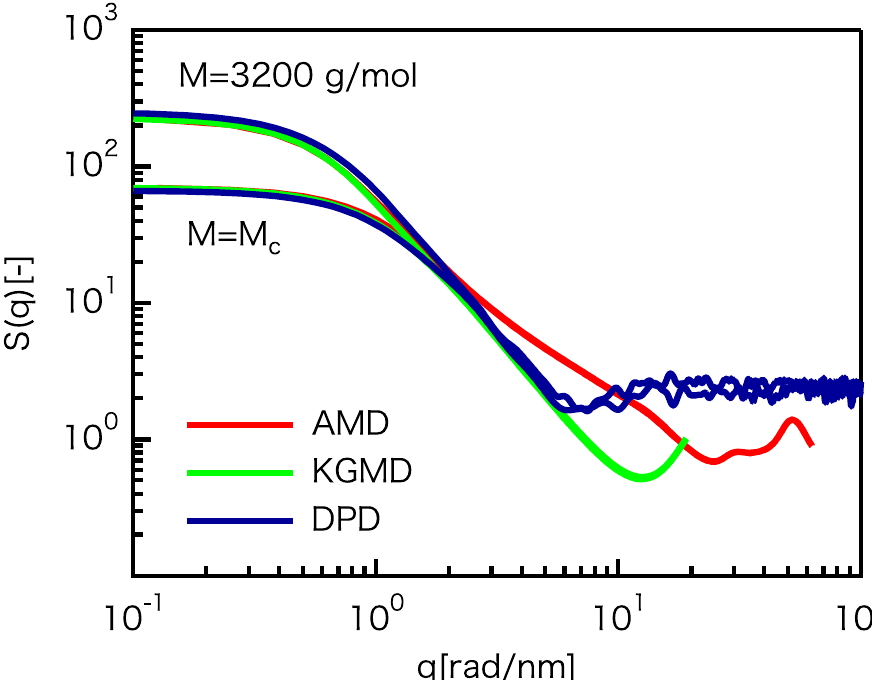
Figure 3. Comparison of the static structure factors for the UA PE model and rescaled CG